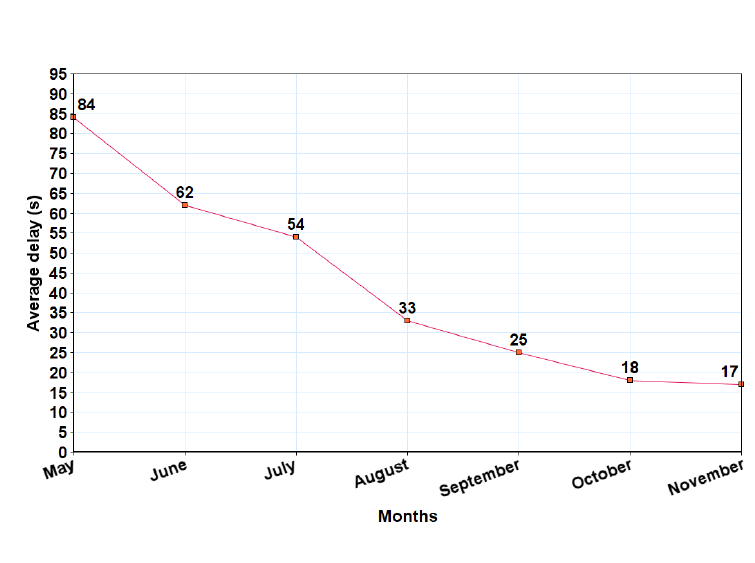
Figure 16. Evolution of the end-to-end delay (average) with time. The more the system is operating, the lower the delay.